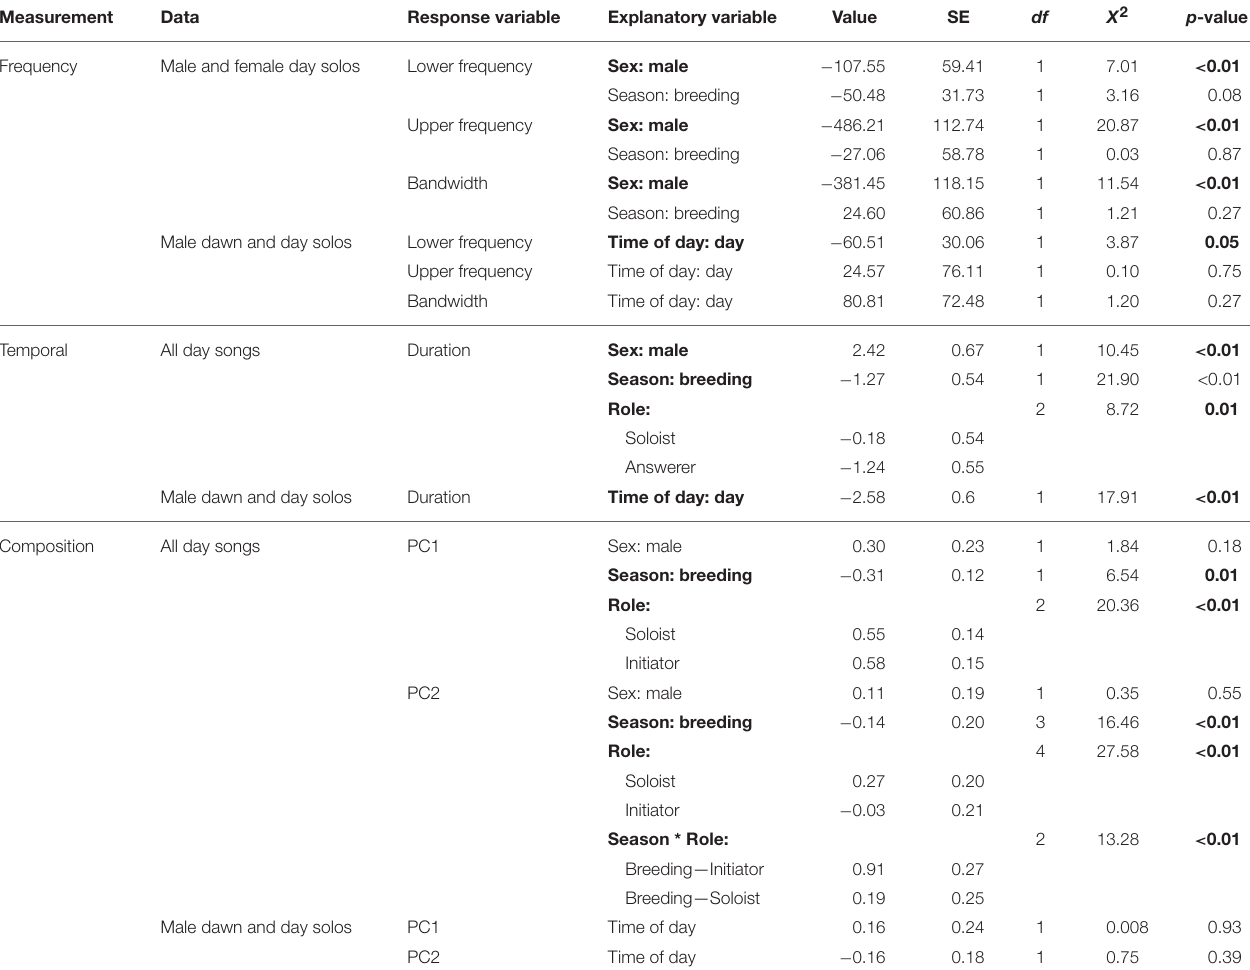
TABLE 4 | Linear mixed effect models indicate the relative effects of sex (male or female), season (breeding or non-breeding), role (solo, duet initiation, or answer) and time of day (dawn or day) on structural frequency, temporal, and composition measurements of troupial songs. Measurement